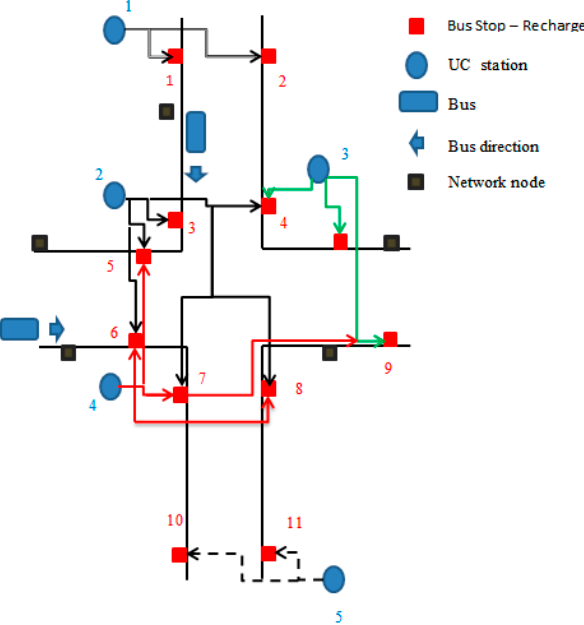
Figure 12. Example of flash charge network.